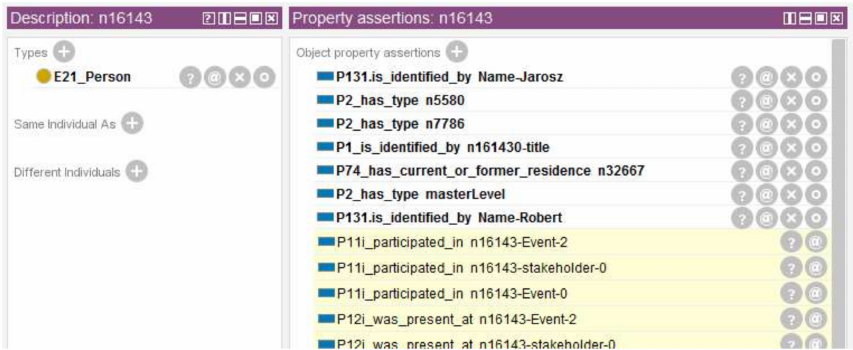
Figure 12. An example of inferred properties for a person